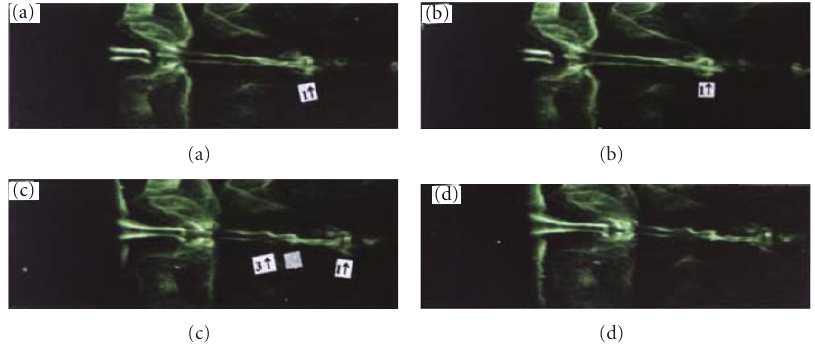
Figure 11: Evolution of the ring-like vortex chain by experiment